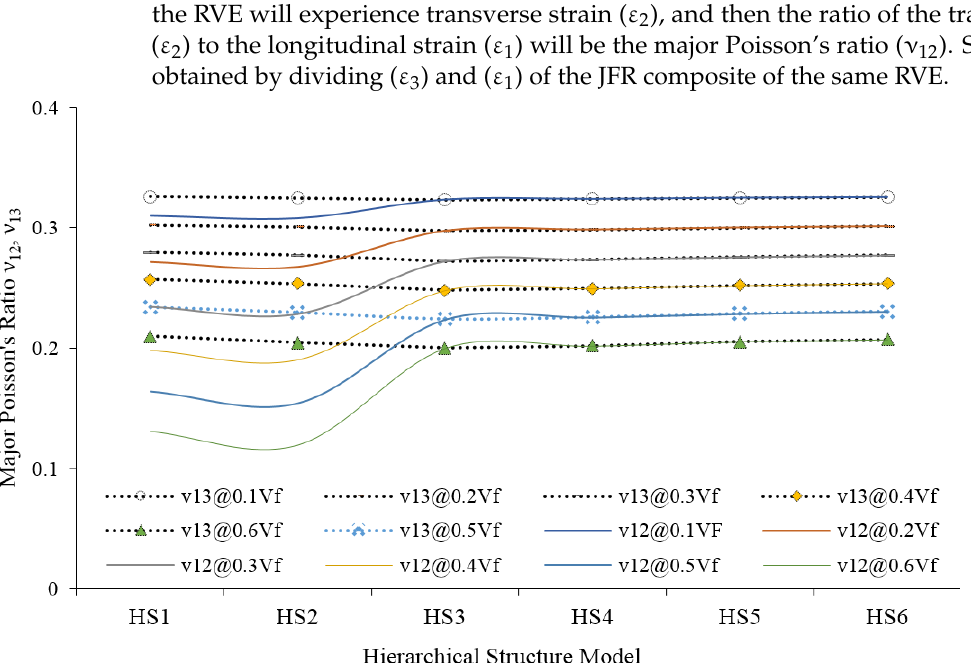
23 ) of Jute fiber composites.